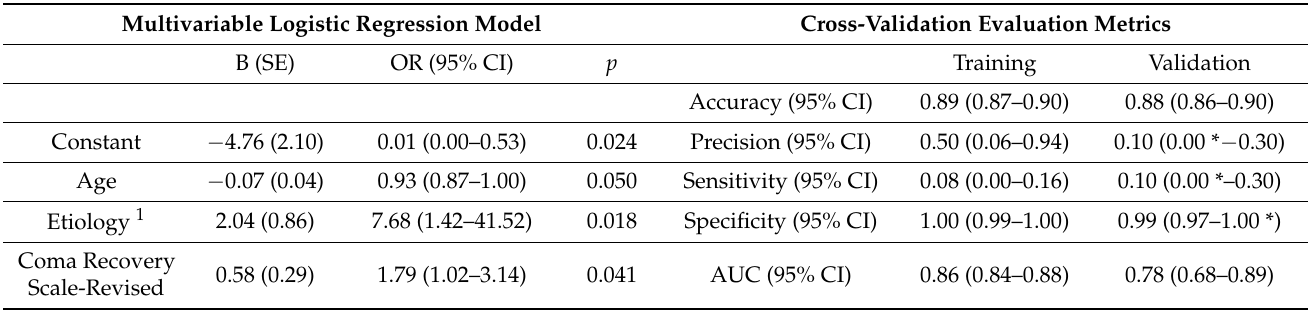
Table 5. Parameters and validation metrics of the predictive model of emergence from Minimally Conscious State. Multivariable Logistic Regression